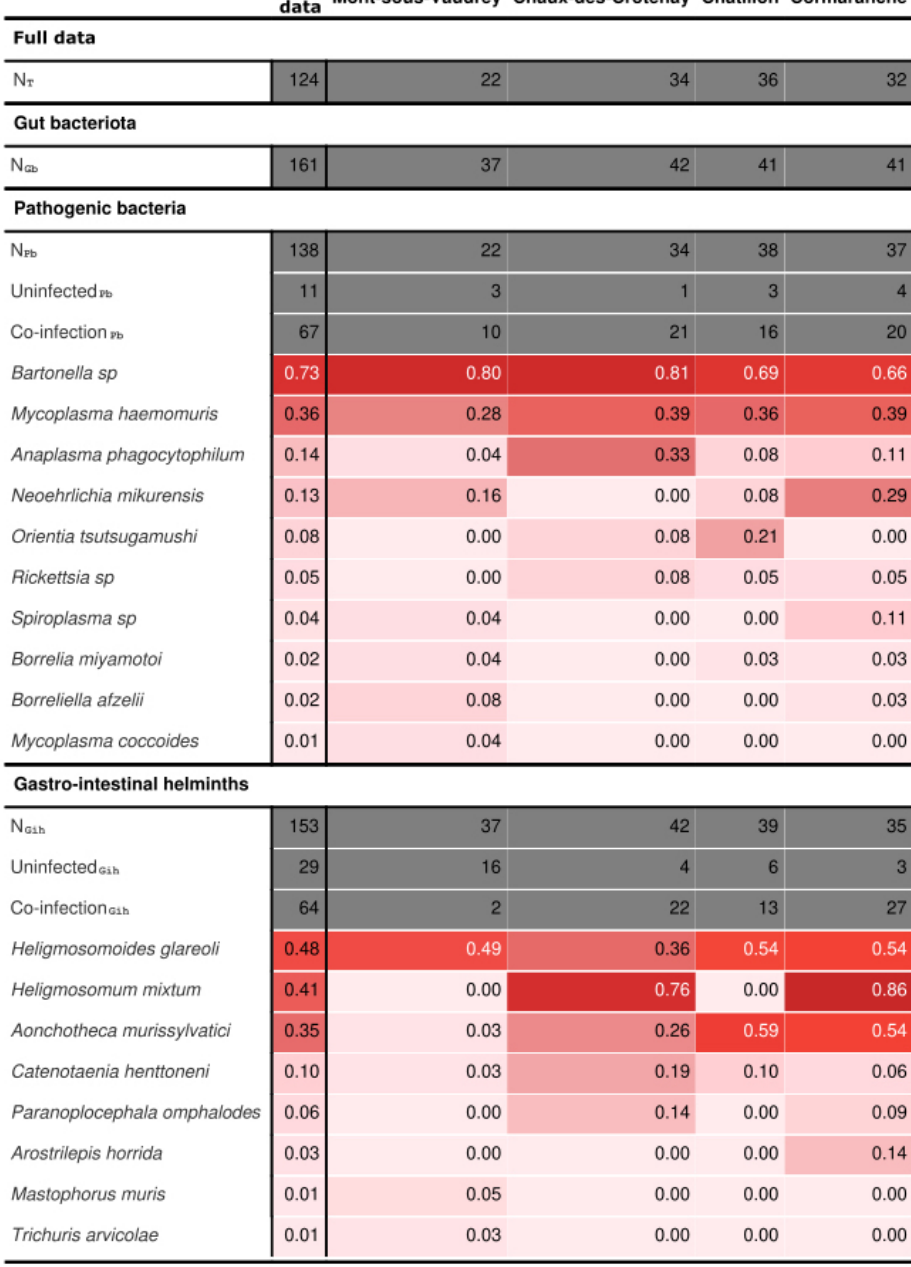
Table 1- Number of bank voles analysed and prevalence of potentially pathogenic bacteria and gastro-intestinal helminths for each sampling locality. N is the number of bank voles analysed (Grey cells). N T represents the number of individuals with data available for the three intra-host communities (gut bacteriota, pathogenic bacteria and gastro-intestinal helminths). N GB , N PB and N GIH respectively represent the number of individuals with data available for each of these intra- host communities. ‘ Uninfected’ corresponds to the number of uninfected bank voles for a given intra-host community. ‘ Co- infection’ corresponds to the number of bank voles infected with at least two parasites of a given intra-host community. Prevalence is provided for each pathogenic bacteria detected from the spleen, and each gastro-intestinal helminth. The red color gradient illustrates variations in prevalence (0% = light red to 100% = dark